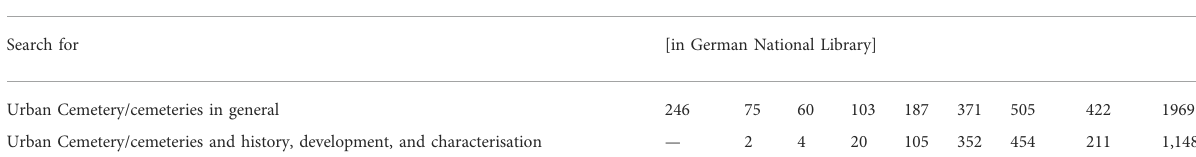
TABLE 2 Studies and scienti fi c publications on cemeteries per year detected by the systematic keyword search (22.02.2022, see Table 1) within the German National Library and the Web of Science and Scopus.